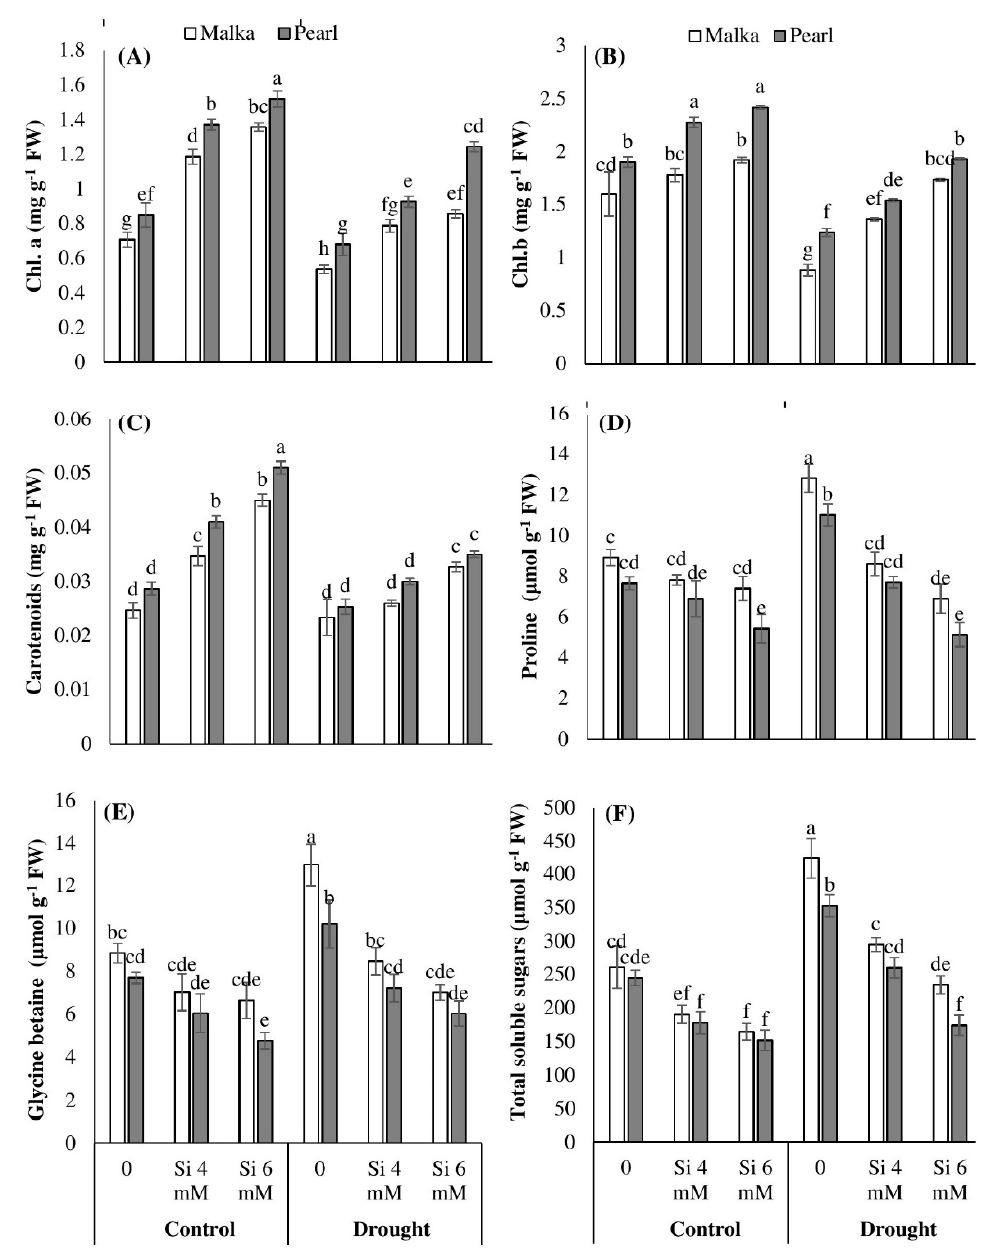
Figure 2. Effect of seed priming with silicon on ( A ) chlorophyll a, ( B ) chlorphyll b, ( C ) carotenoids, ( D ) proline, ( E ) glycine betaine, and ( F ) total soluble sugar contents in two maize cultivars under drought stress. Mean with same letter(s) do not differ significantly at p < 0.05. Error bars above the means indicate standard error ( n = 3).